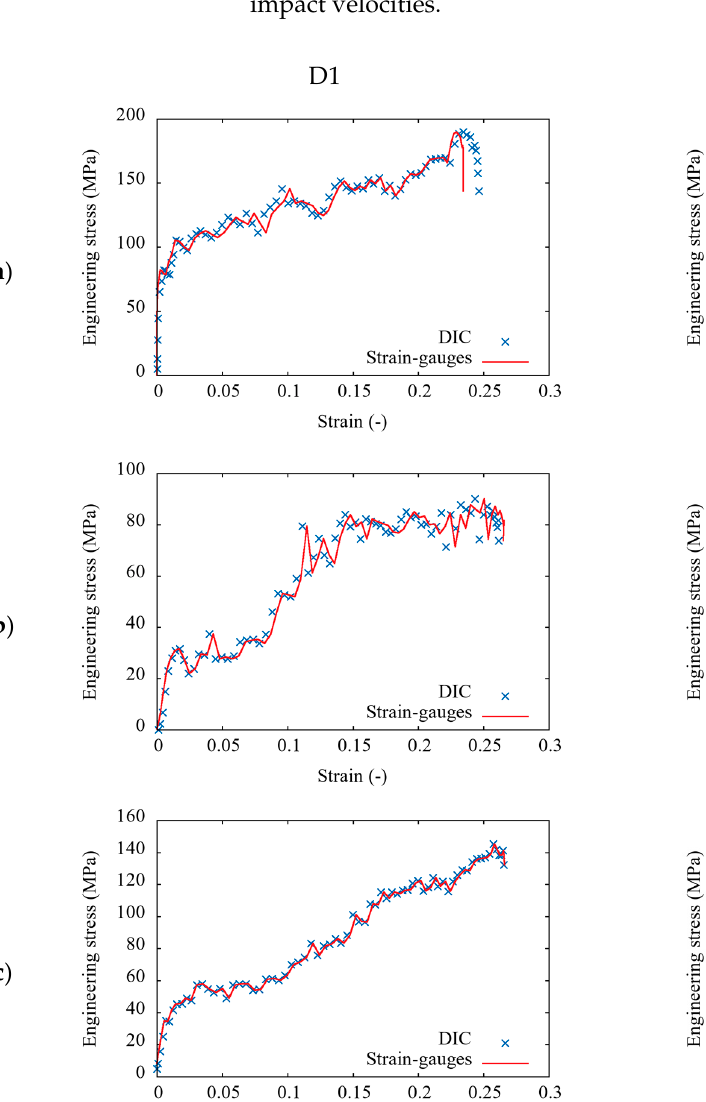
Figure 7. Evolution of full-field longitudinal strain of ( a ) hexa-chiral 2D, ( b ) tetra-chiral 2D, and ( c ) tetra-chiral 3D structure during impact testing at lower (D1) and higher (D2) impact velocity.